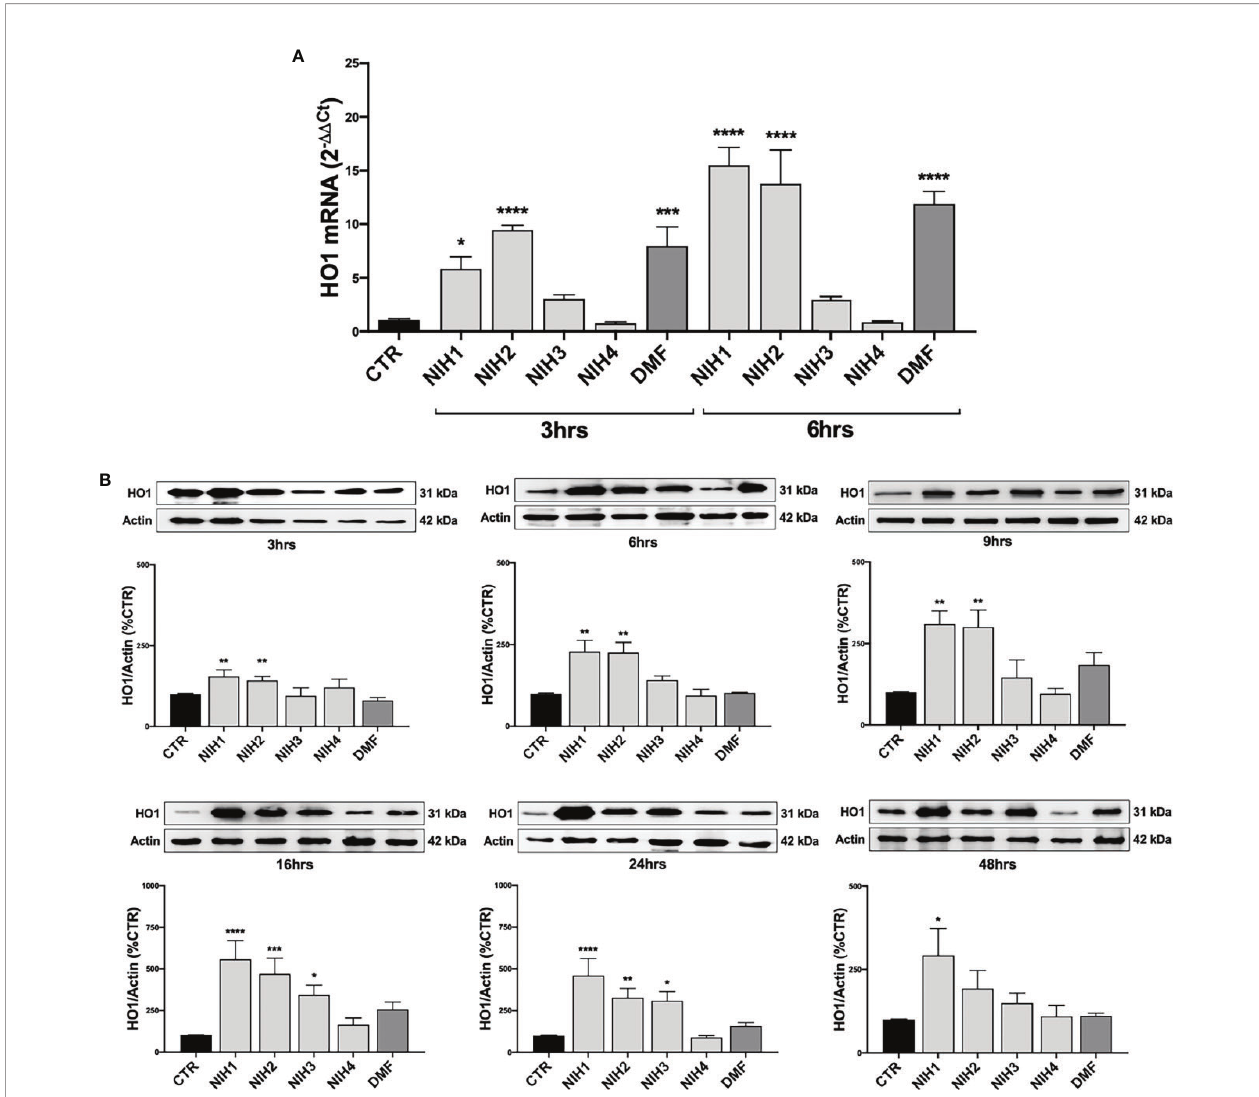
FIGURE 4 | The NIH-mediated increase of HO1 expression vary among molecules. (A) Total HO1 mRNA levels were measured by RT-qPCR in ARPE-19 cells exposed to either solvent (DMSO, CTR), NIH1, NIH2, NIH3 and NIH4 [5 m M], or DMF [10 m M], for 3 and 6 h. GAPDH mRNA content was used as a housekeeping to normalize the data. Results are expressed as means of 2 − DD Ct ± SEM. Dunnett ’ s multiple comparisons test; *p <0.05, ***p <0.001 and ****p <0.0001 versus CTR; n = 3. (B) ARPE-19 cells were exposed to either solvent (DMSO, CTR), NIH1, NIH2, NIH3, NIH4 [5 m M], or DMF [10 m M], for increasing times (up to 48 h), and total homogenates were examined by Western blot using an antibody against HO1. Actin was used as a loading control to normalize the data. Results are expressed as mean percentages ± SEM. Dunnett ’ s multiple comparisons test; *p <0.05, **p <0.01; ***p <0.001 and ****p <0.0001 versus CTR; n =